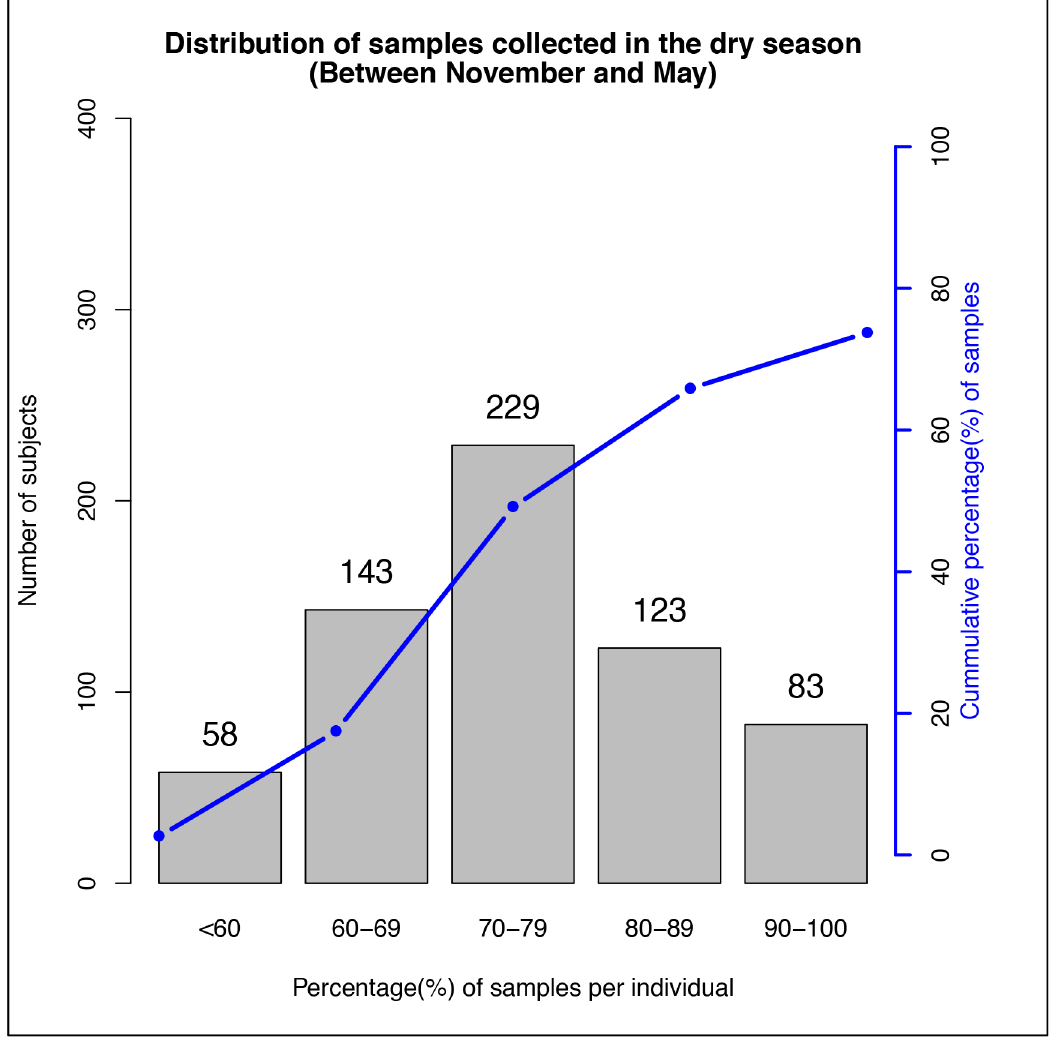
Fig 1. Distribution of samples collected in the dry season. The bar graph shows the distribution of participants based on their percentage of samples collected in dry season. The line graph represents the corresponding cumulative percentage (of the total samples) for the samples collected in the dry season.